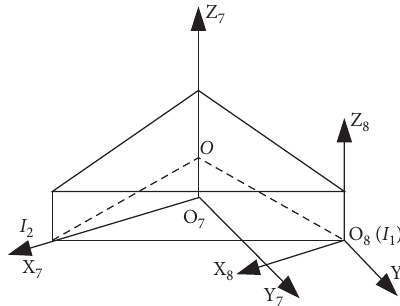
Figure 8: Spatial three-input single-output rigid